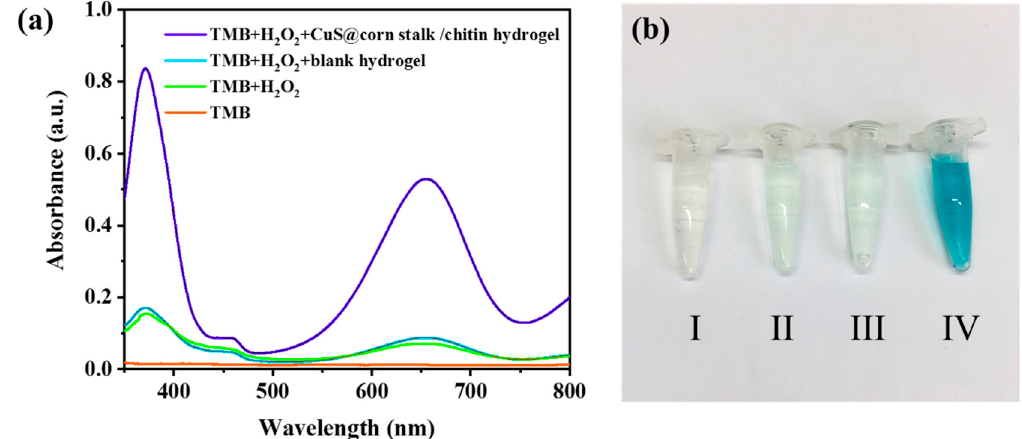
Figure 5. ( a ) UV/vis absorption spectra of different TMB solutions; ( b ) different TMB solutions: (I) TMB, (II) TMB + H 2 O 2 , (III) TMB + H 2 O 2 + blank hydrogel, (IV) TMB + H 2 O 2 + CuS@corn stalk/chitin composite hydrogel.